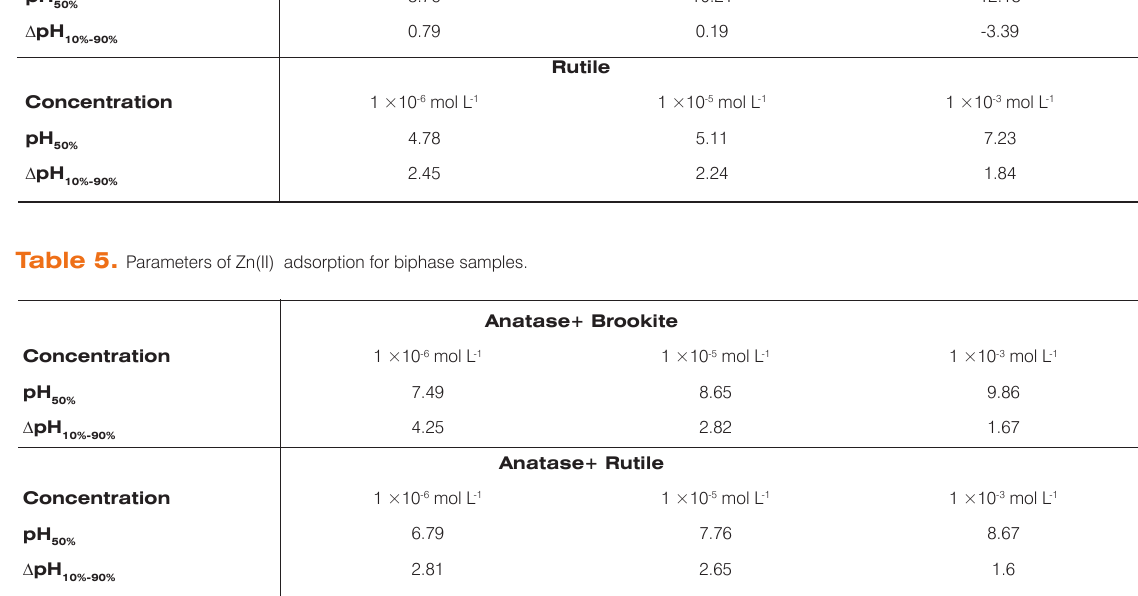
(Fig. 10). For the concentrations of 1×10 -4 and 1×10 -3 mol L -1 of Zn(II) ions CR2 is the same and equals